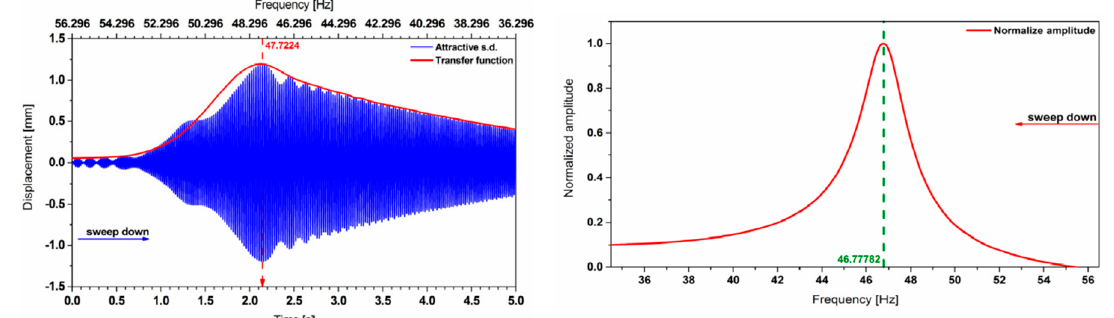
Figure 3. Transient analysis results of the F.E. model for a gap value of 16 mm, showing the frequency shift of the initial resonance ( left ) compared to the compact lumped spring-mass-damper resonator results ( right